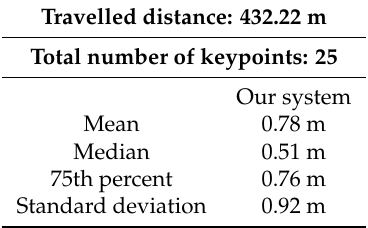
Figure 14. Experiment 1: errors at each keypoint. Table 3. Experiment 1: error